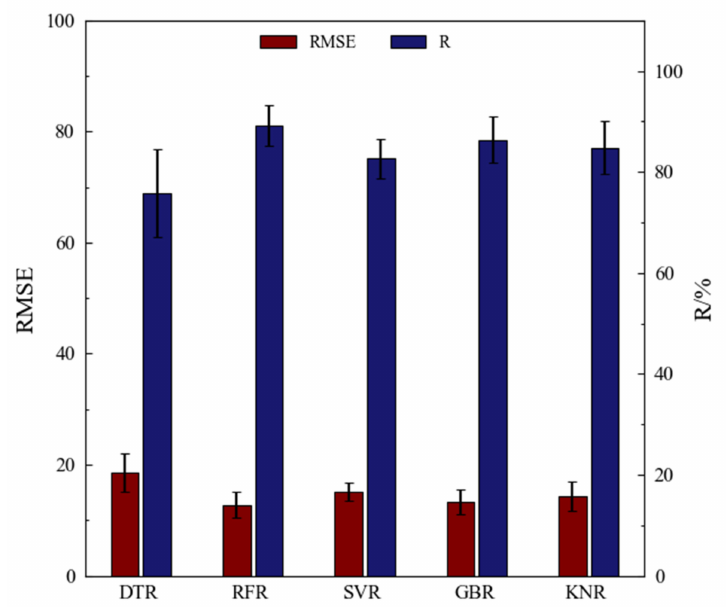
Figure 2. The correlation coefficient ( R ) and the root mean square error (RMSE) , using different ensemble methods on the testing set.